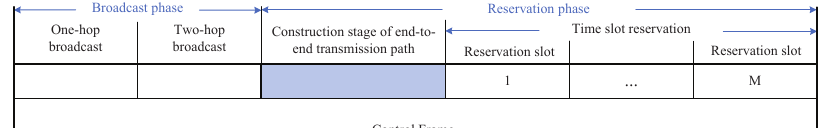
Figure 3. The control frame